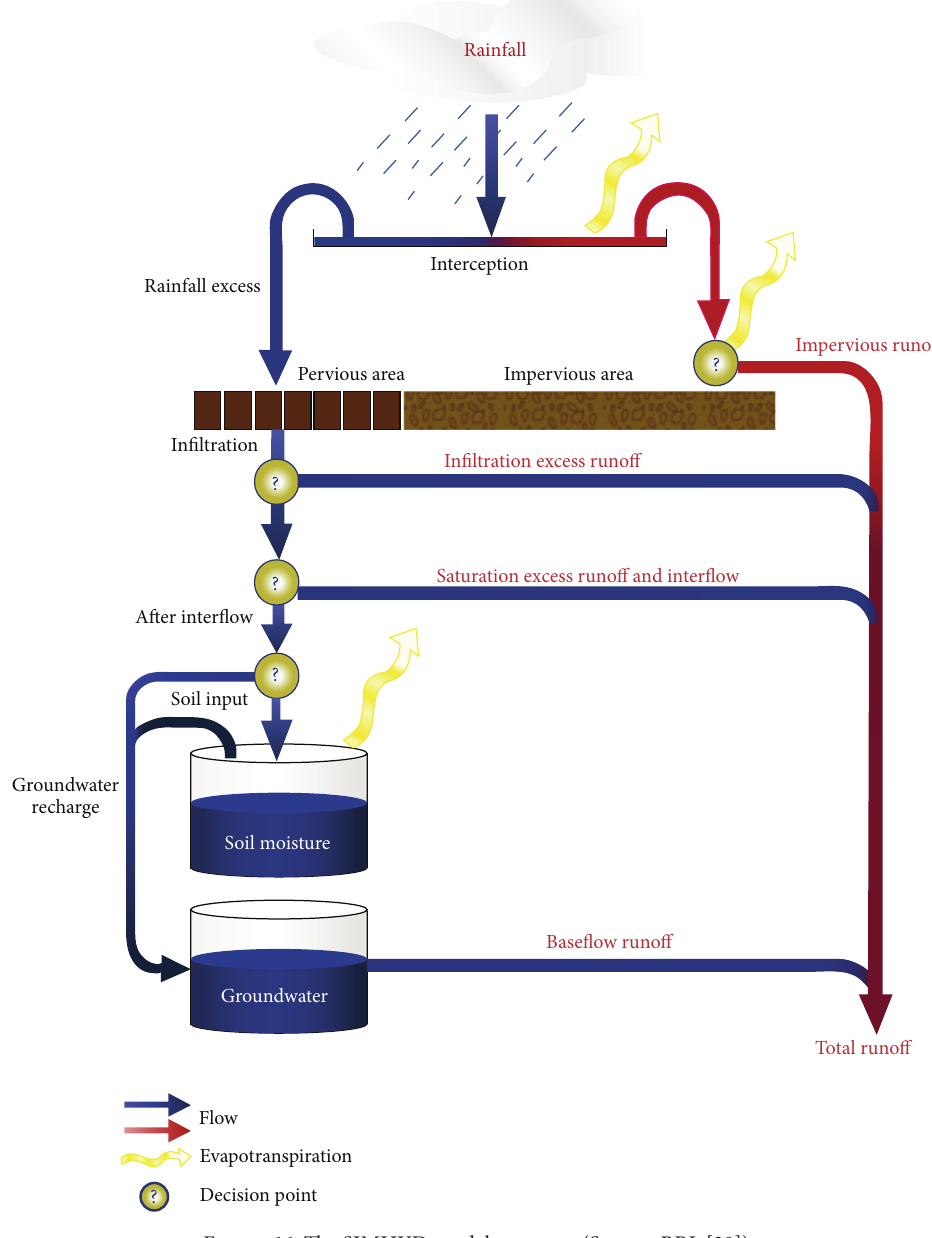
Figure 16: The SIMHYD model structure (Source: RRL